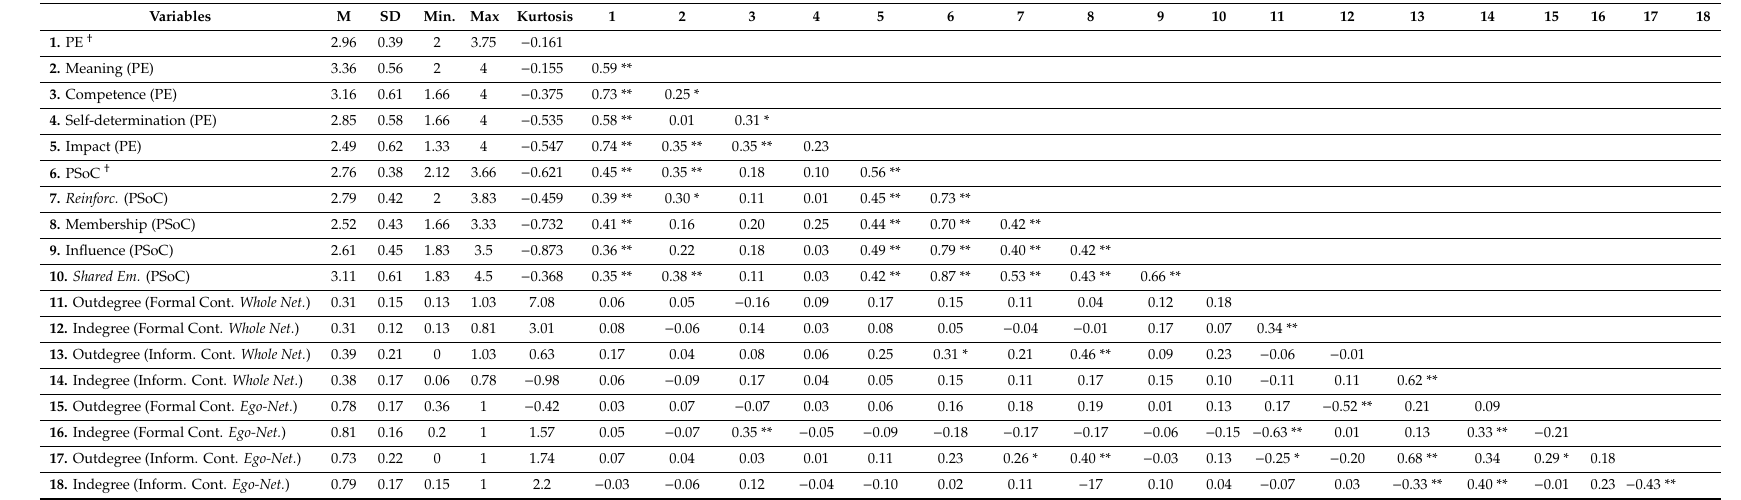
Table 1. Matrix of bivariate correlations among the PE and PSoC dimensions and centrality measures in formal and informal networks at whole and egocentric levels. Variables